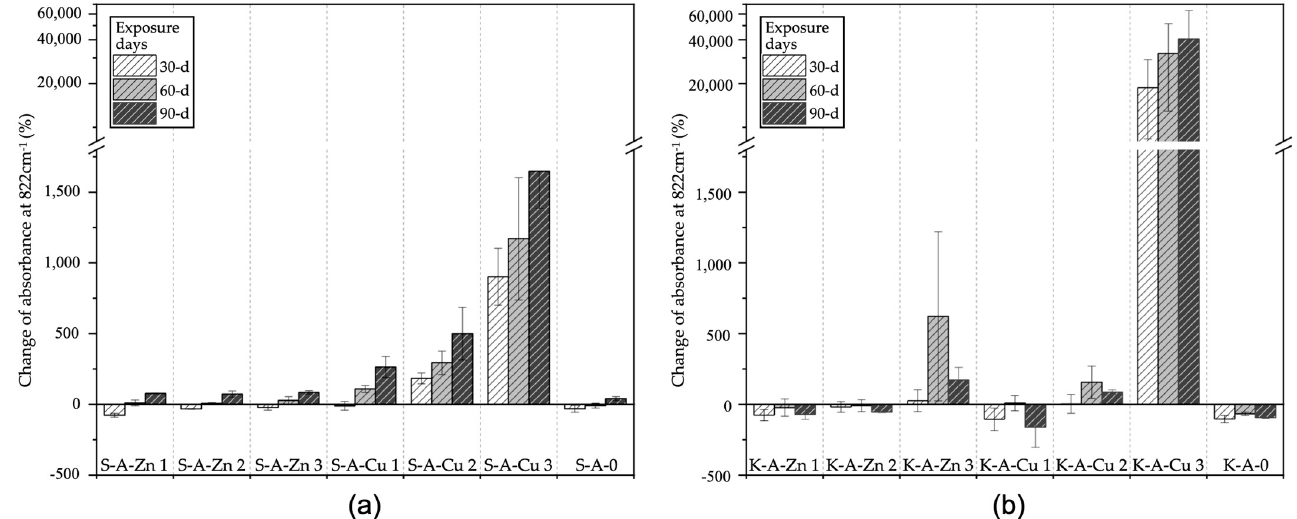
Figure 6. The average change in absorbances at 822 cm − 1 with the exposure day: ( a ) Sugi samples; and ( b ) Keyaki samples ( n = 3).